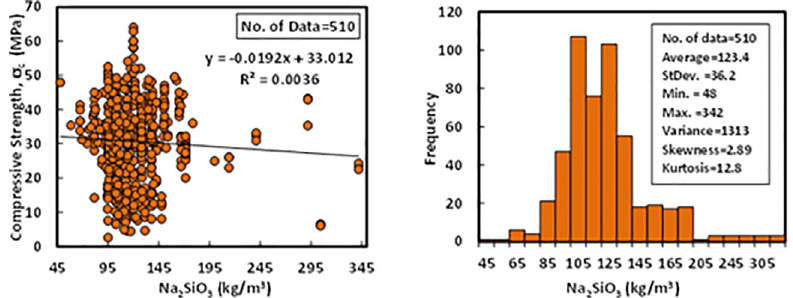
Fig 8. Variation between compressive strength and sodium silicate content with histogram of fly ash-based geopolymer concrete mixtures.